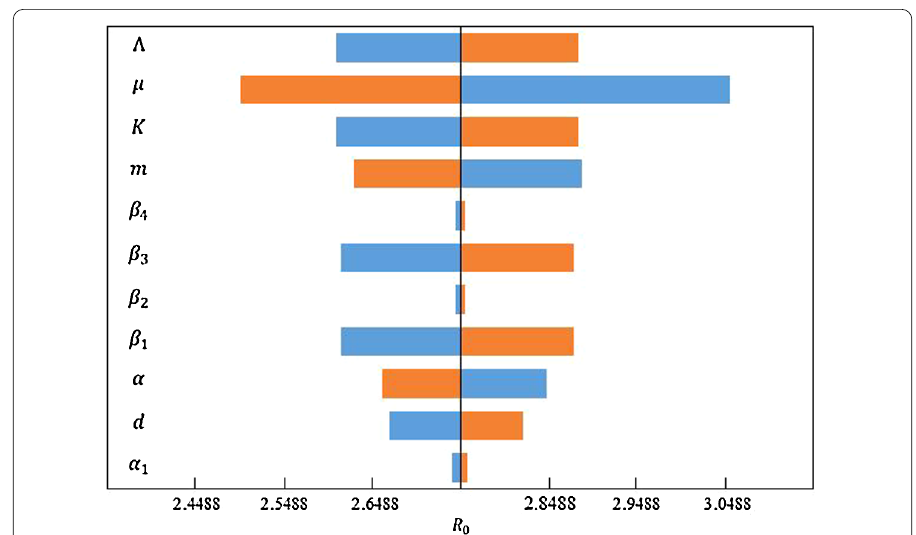
Figure 2 The sensitivity of R 0 to changes in constant parameters. Each parameter is varied by 10% to assess the impact on R 0 . Decreasing each parameter by 10% (e.g., 0.9 α ) is indicated in blue; increasing each parameter by 10% (e.g., 1.1 α ) is indicated in orange.